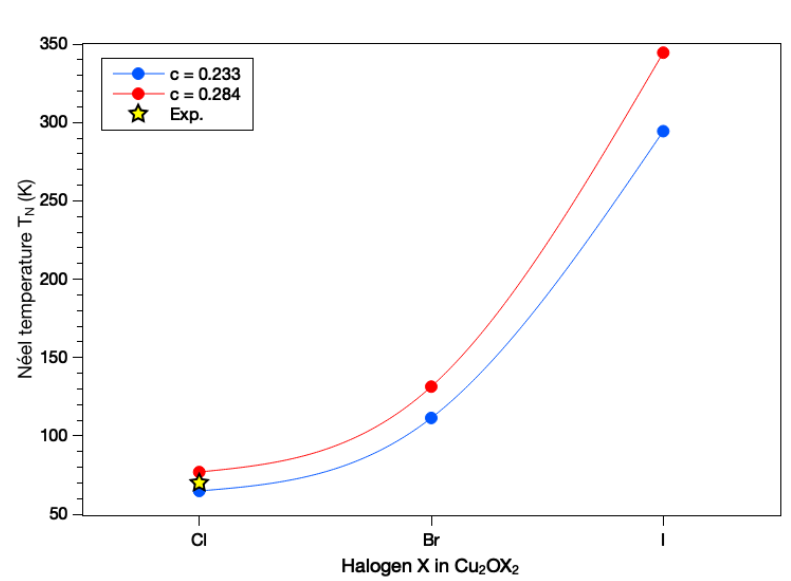
Figure 8. Estimation of the T N Néel temperature depending on the nature of halogen species and considering two sets of parameters for the magnetic model presented in Equation (2): (1, in blue) α = 2.6 and c = 0.233, and (2, in red) α = 2.6 and c = 0.284. The experimental value for Cu 2 OCl 2 is represented by a yellow